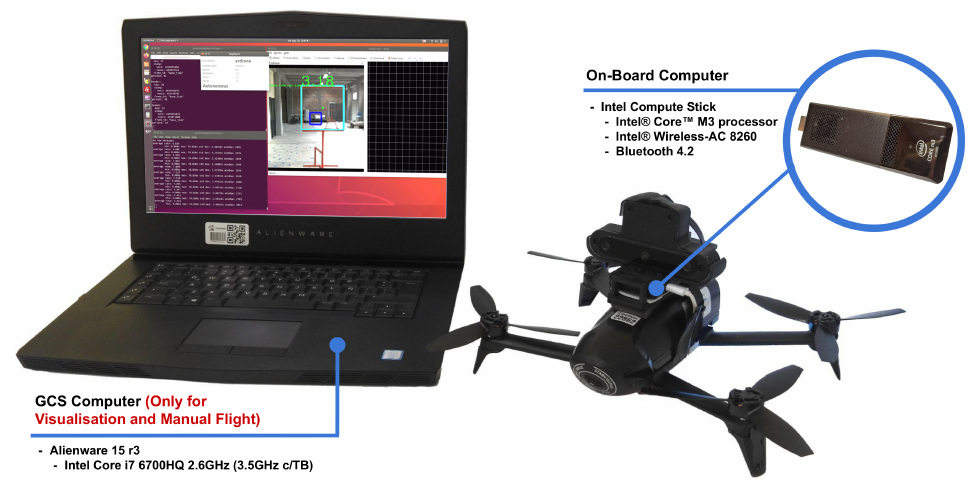
Figure 10. GCS and the Bebop 2.0 PWE with the Intel Stick and the OAK-D camera on